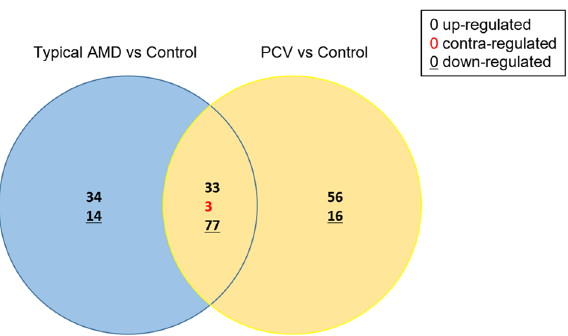
Figure 1. Venn diagram illustrating miRNAs detected in typical AMD and PCV eyes. AMD age-related macular degeneration, PCV polypoidal choroidal